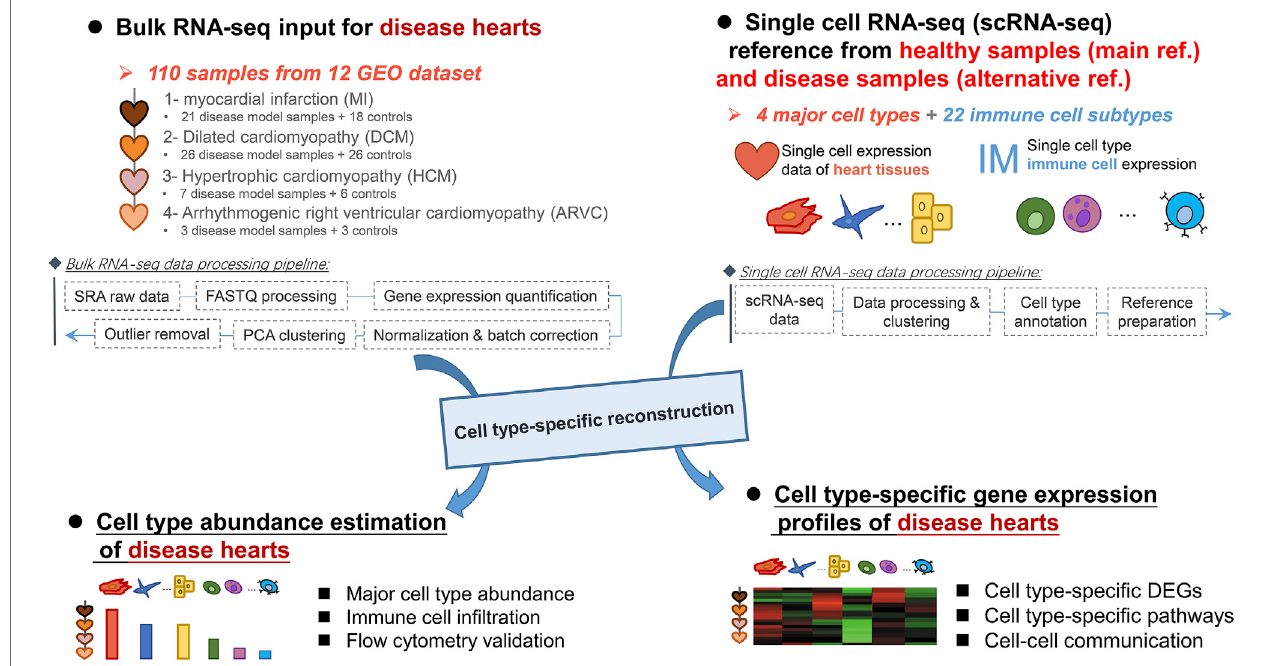
FIGURE 1 | Work fl ow of the data processing and analysis